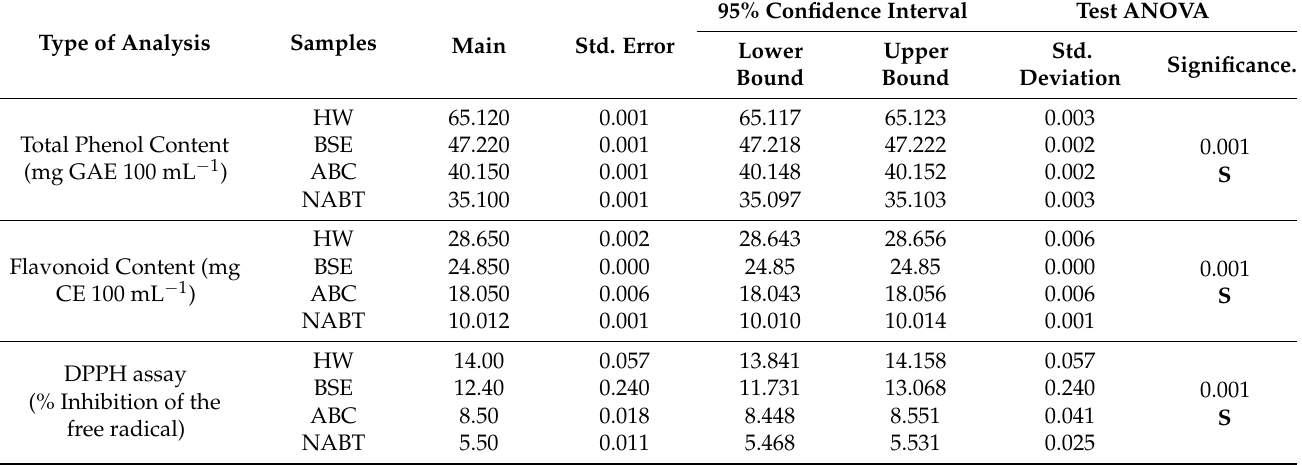
Table 4. Statistical analysis of the means performed by one-way analysis of variance